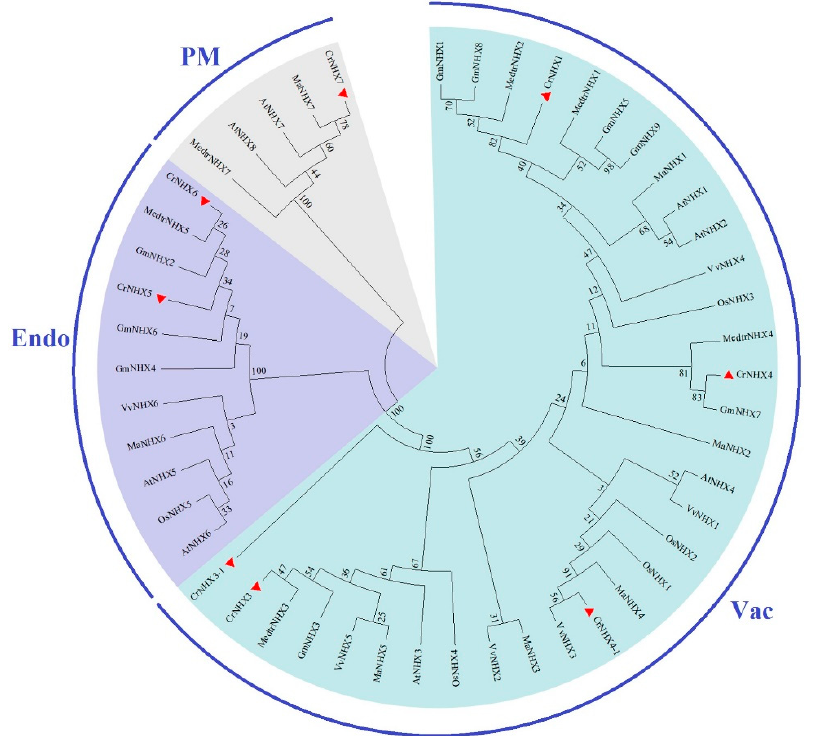
Figure 2. Phylogenetic relationships of the eight CrNHXs from C. rosea , eight AtNHXs from A. thaliana , five OsNHXs from O. sativa , six VvNHXs from V. vinifera , nine GmNHXs from G. max , six MedtrNHXs from M. truncatula , and seven MaNHXs from M. atropurpurea . The phylogenetic tree was constructed with protein sequences using MEGA 6.0 software, with ClustalW alignment, neighbor-joining (NJ) method, and 1000 bootstrap repetitions. All three subfamilies (Vac-, Endo-, and PM-) of the NHX family are well separated into different clades and are represented by different colored backgrounds.